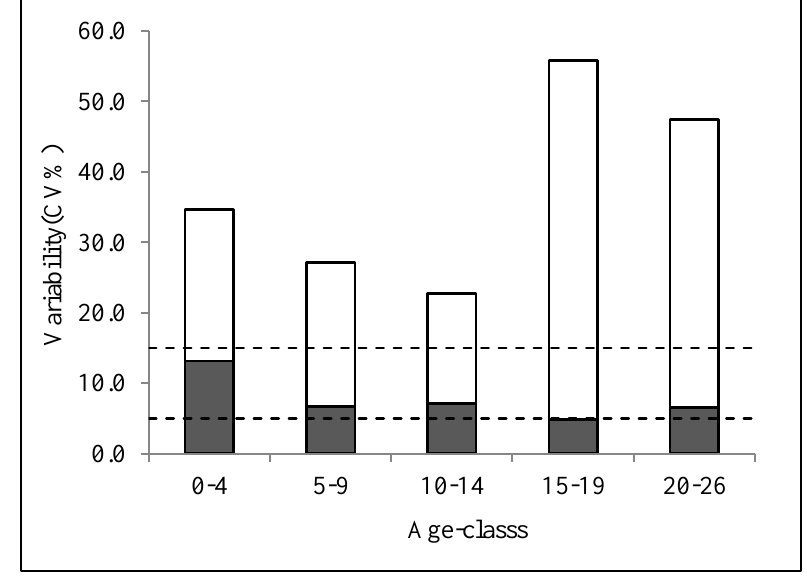
Fig. 2. Variability in average RTLs estimated each age-classes divided into experimental variability (average CV of individual RTL estimates; dark grey) and biological variability (the difference between overall variability in RTL and experimental variability; white). The stippled lines mark the range of RTL CVs reported in recent applications of the multiplex qPCR telomere assay (Aviv et al. 2011; Cawthon 2009; Kim et al.